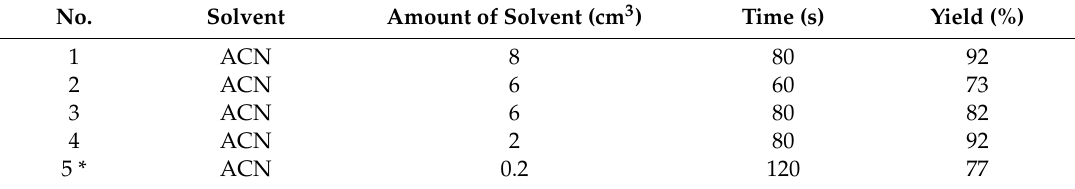
Table 4. Synthesis of trazodone with method II—10 mmol of 1-(3-chloropropyl)-4-(3- chlorophenyl)piperazine hydrochloride ( 5 ), (10 mmol) of 1,2,4-triazolo[4,3-a]pyridin-3-(2 H )-one ( 1 ), 10 mmol of TBAB, 30 mmol of K 2 CO 3 .